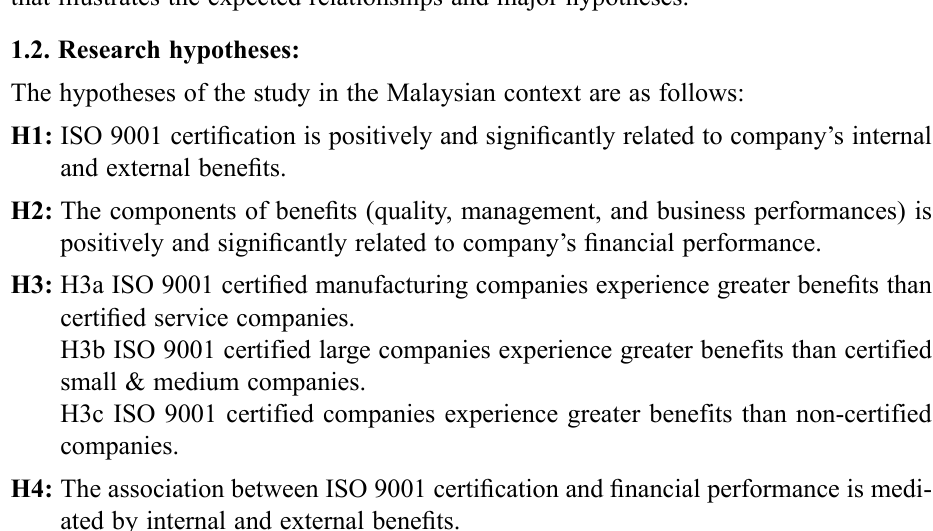
HR Mgt.Performance